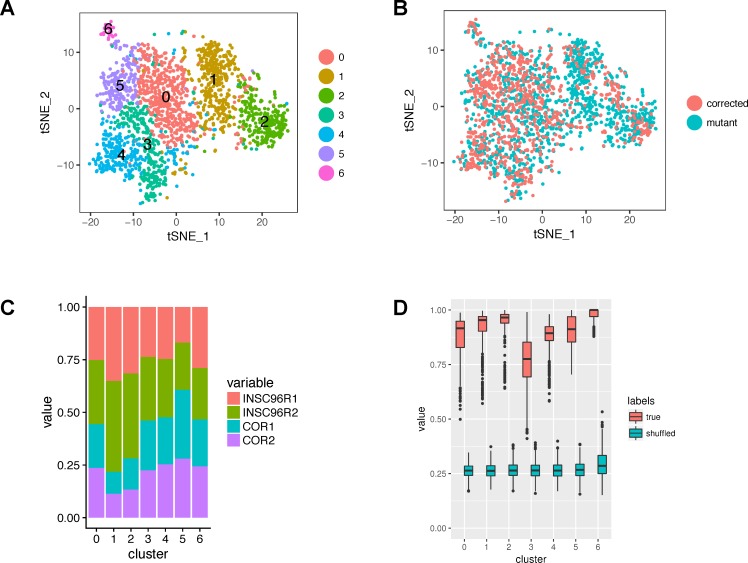
Cluster composition and robustness.(A) A tSNE plot showing the original clusters (before merging and refinement) identified by Seurat. (B) The same tSNE plot with cells colored by mutation status. (C) Bar graph showing the proportions of samples within the original clusters. (D) Robustness of clusters. The boxplots show the maximum proportions of co-clustered cells from a given original cluster in 1000 subsampling runs. The proportions are shown also for the null distribution of shuffled cell-cluster pairs.